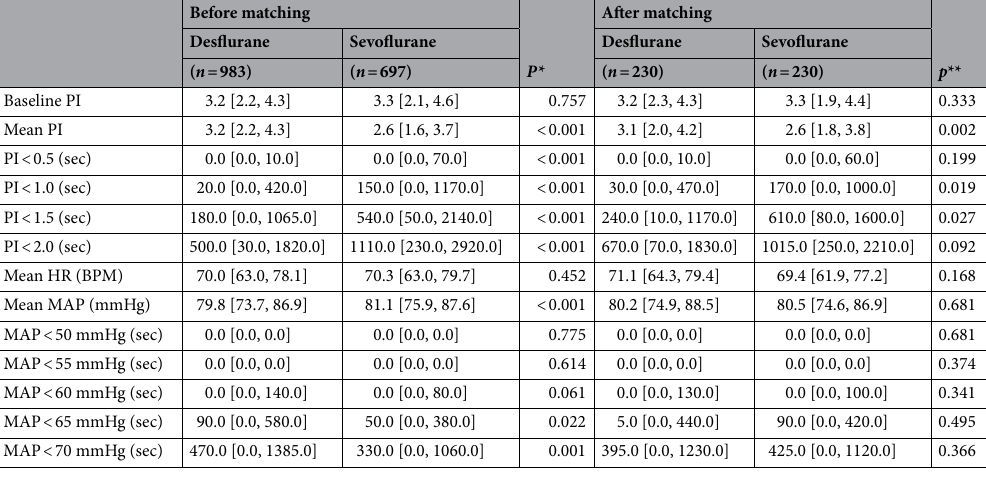
Table 2. Outcomes according to inhalation agents before and after propensity score matching. PI perfusion index, HR heart rate, BPM beat per minute, MAP mean arterial pressure. *Results of unpaired tests. **Results of paired tests. Continuous data are reported as median (interquartile